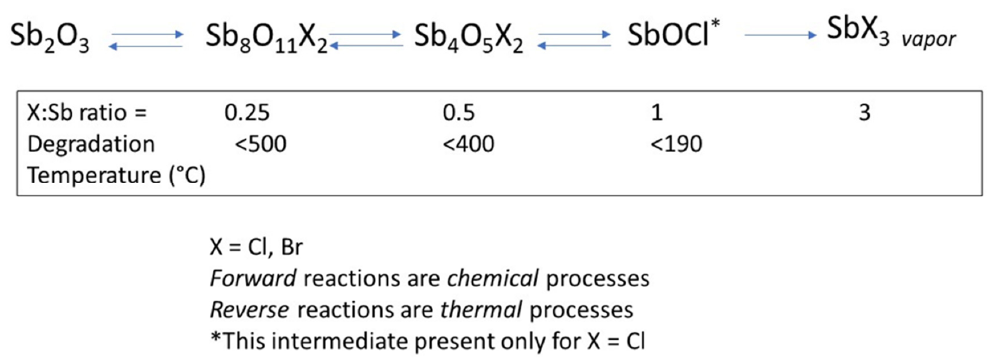
Figure 2. Thermal stability of chlorine, bromine, and antimony additives [7].